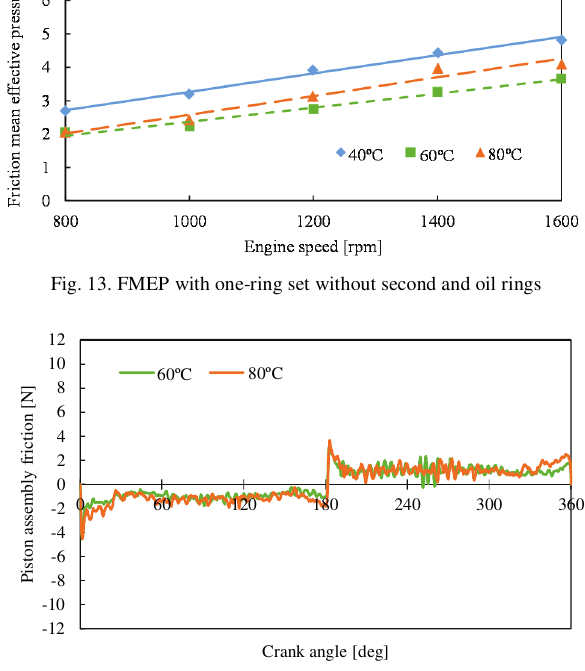
Fig. 14. Effect of temperature on piston assembly friction with one-ring set at 1000 rpm At 40°C, 60°C, and 80°C at between 800 rpm and 1200 rpm, the one-ring set (of only the top ring) minimized the FMEP. The FMEP was reduced by 27% to 56% for the one-ring set compared to the three-ring set. At 80°C at more Fig. 11. Effect of absence of oil ring on piston assembly friction at 40°C than 1200 rpm, the two-ring set (with the top and the oil and 1000 rpm rings) minimized the FMEP. The FMEP was reduced by 18% for this two-ring set (with the top and the oil rings) compared to the three- ring